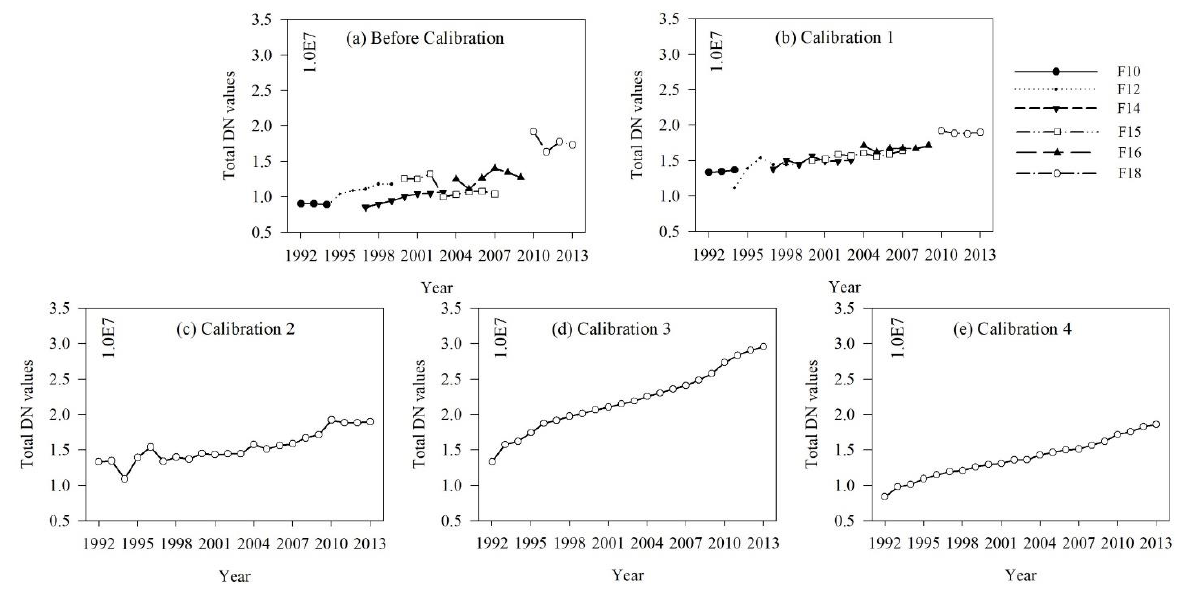
Figure 4. Comparisons of the total DN values at different calibration stages for Africa: ( a ) Original NTL data; ( b ) Inter- calibration; ( c ) Intra-annual composition; ( d ) Inter-annual series correction; ( e ) Enhancement of variability.